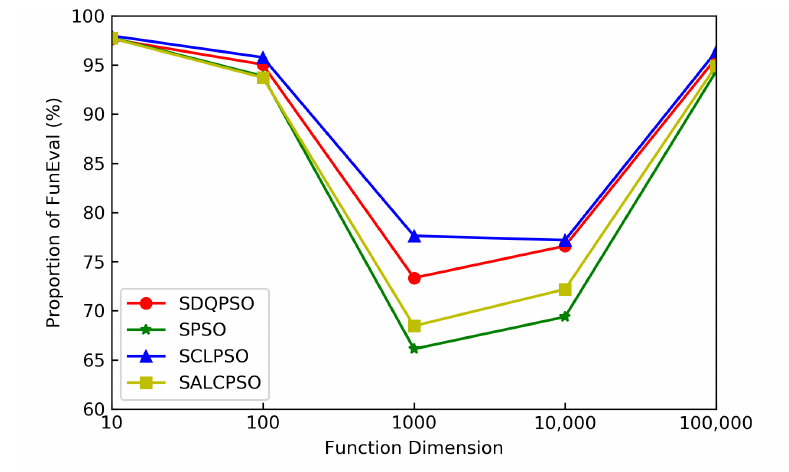
Figure 8. The function evaluation proportion under different